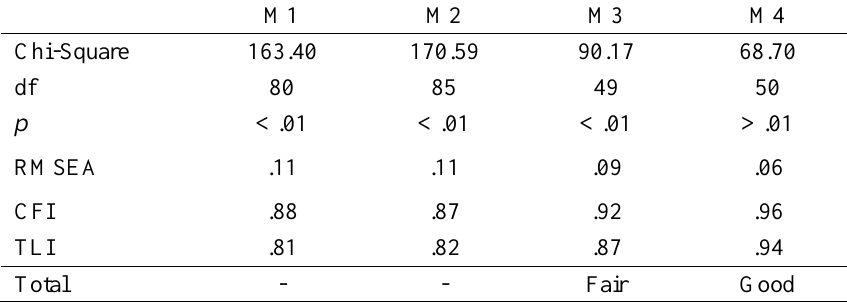
Goodness-of-model-fit indices for four proposed models